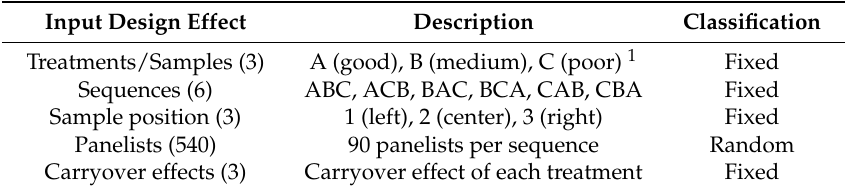
Table 2. Description of the input design effect for the grape juice consumer